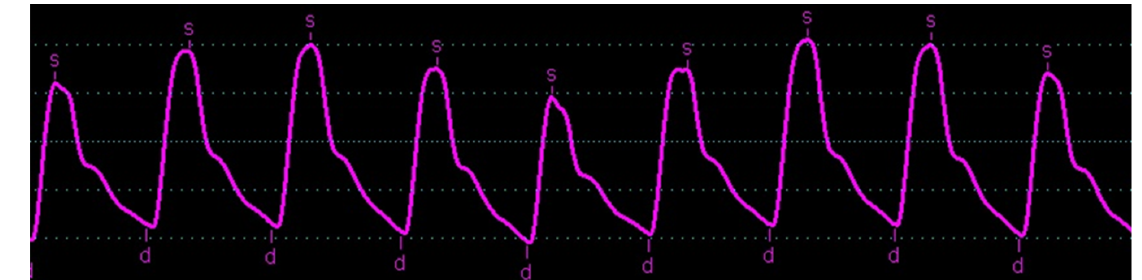
Figure 13. Illustration of the normal respiratory variation of the central blood pressure curve as intrathoracic filling pressures flux with inspiration and expiration, and so potentially limiting any accuracy of methods comparison. S represent systolic blood pressure and d represent diastolic blood pressure.